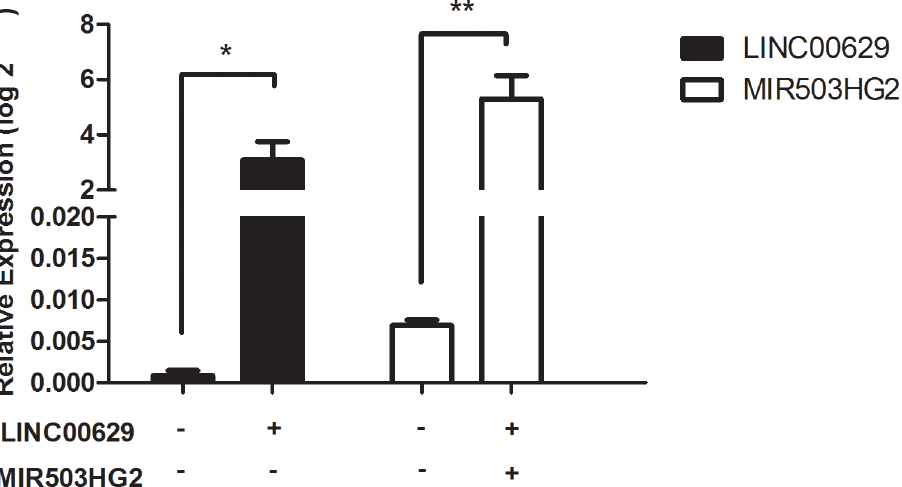
Fig 9. MIR503HG2 or LINC00269 were overexpressed in JEG-3 cell line. Plasmidial expression vectors containing MIR503HG2 or LINC00629 full-length sequences were transfected into JEG-3 cell line. Relative expression was analyzed by RT-qPCR normalized by the geometric mean from GAPDH and HPRT endogenous genes. The empty plasmid was used as a control. * p < 0.05 and ** p < 0.01 ( t